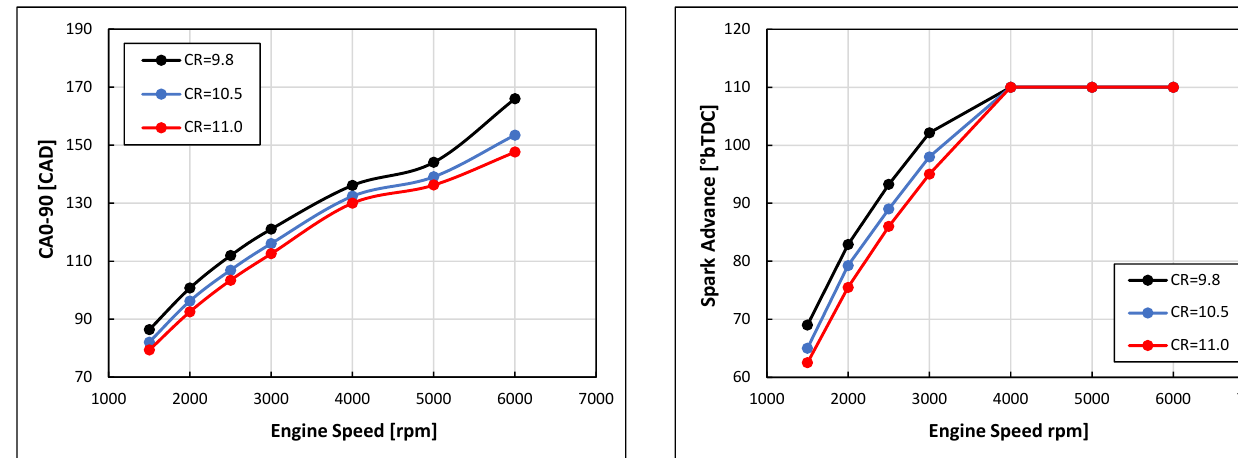
Figure 11. Combustion duration ( left ) and optimal spark advance ( right ) for different compression ratios. φ = 1, WOT, no boost.